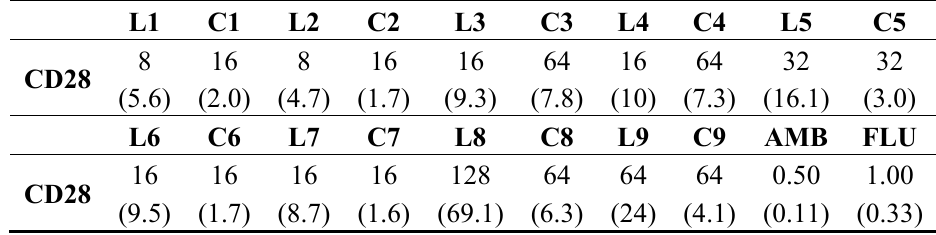
Table 4. In vitro susceptibility of clinical isolates of Paracoccidioides brasiliensis for pentakis-dithiocarbamate by